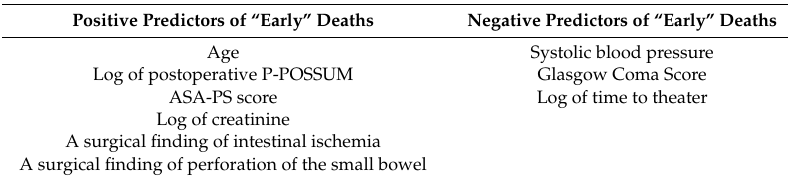
Table 3. Characteristics that compose positive and negative predictors of early deaths in emergency laparotomy. A full analysis can be found in Appendix